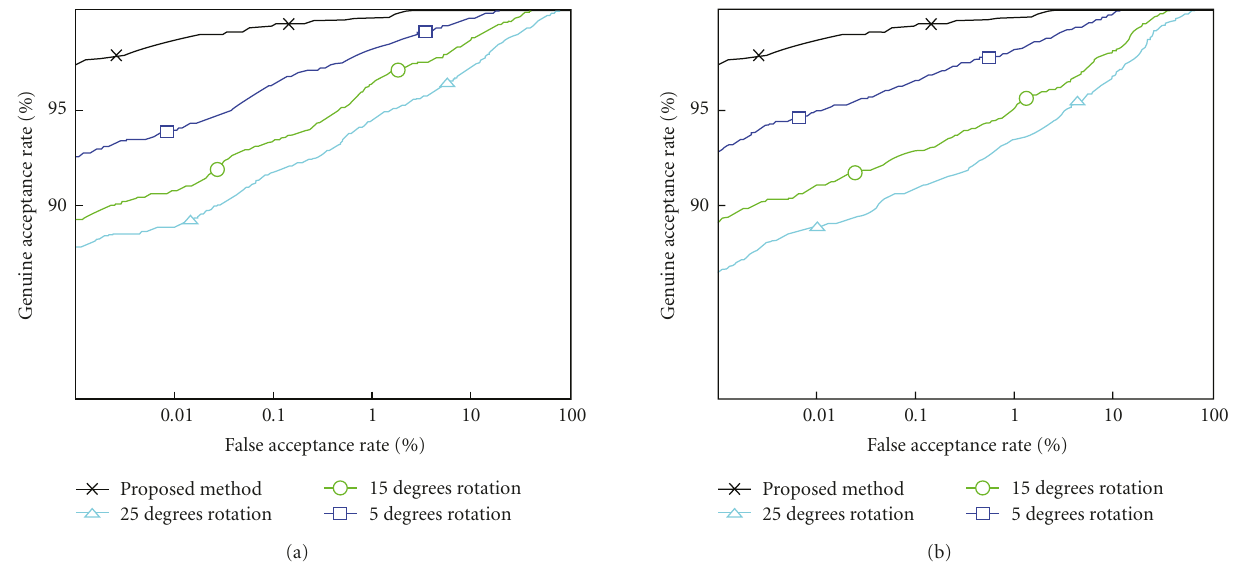
Figure 20: ROC curves of proposed method in comparison with best results of Boles and Boashash [10], Daugman [5], Ma et al. [7], Monro et al. [15] and Sun et al. [29] methods with iris rotations (5, 15, and 25 degrees clockwise) using (a) CASIA-IrisV3 and (b) Bath iris database. 5, 15, and 25 degrees rotation, compared to Boles